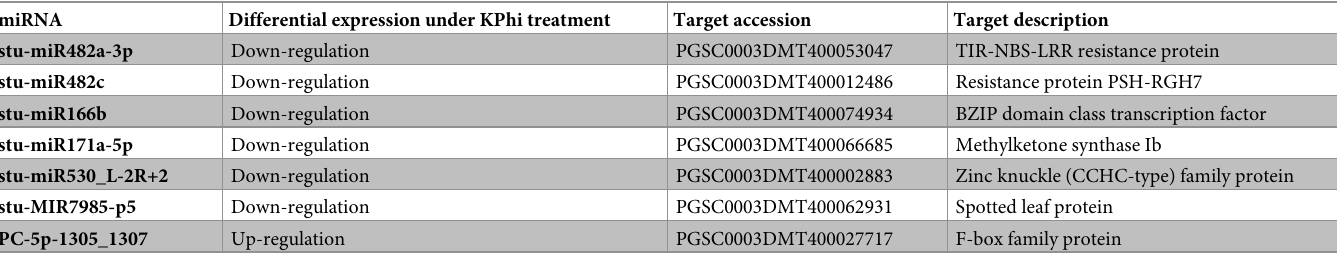
Table 2. Selected differentially expressed miRNAs after KPhi treatment and targets.